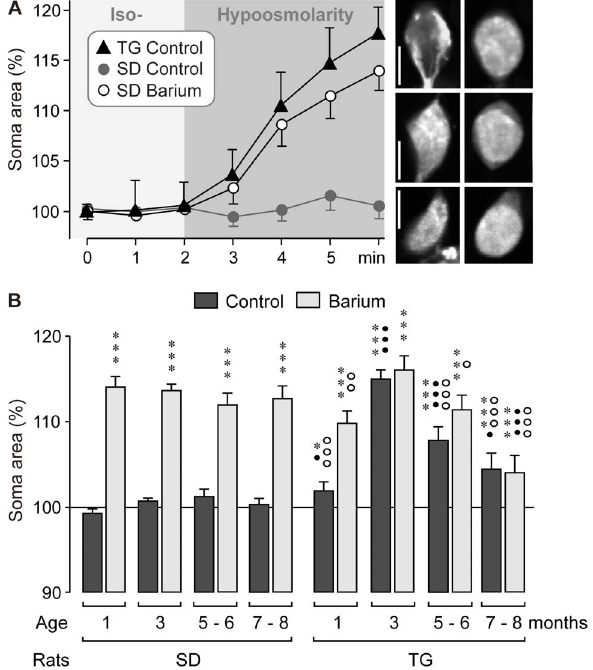
Figure 8. Age-dependent alterations in the osmotic swelling characteristics of Mu¨ller cell somata. Mu¨ller cell somata were recorded in retinal slices from control (SD) and transgenic (TG) rats. A. Time-dependent alterations in the mean cross-sectional area of cell somata (n=7–8 cells each) during the change from isoosmotic to hypoosmotic extracellular solution (60% osmolarity) in slices from 3- Figure 9. Involvement of oxidative-nitrosative stress and months animals. Cells in slices from SD animals were recorded in the inflammatory lipids in the induction of osmotic Mu¨ller cell absence (control) and presence of barium chloride (1 mM). The images swelling. Retinal slices from 3-months control (SD; A ) and transgenic display original records of Mu¨ller cell somata in slices from 3-months TG (TG) rats ( B ) were used. The cross-sectional area of Mu¨ller cell somata rats ( above and middle ) and a SD rat ( below ) obtained before ( above ) was measured after superfusion of the slices with hypoosmotic solution and during ( below ) superfusion with hypoosmotic solution in the for 4 min, and is expressed in percent of the soma size recorded before absence (TG rats) and presence of barium (SD rat). Bars, 5 m m. B. Mean hypoosmotic challenge (100%). A. The following agents induced cross-sectional area of Mu¨ller cell somata in dependence on the age of swelling of Mu¨ller cell somata in slices from control animals superfused the animals. The hypoosmotic solution was tested in the absence with hypoosmotic solution: barium chloride (1 mM), H 2 O 2 (100 m M), the (control) and presence of barium chloride (1 mM). The data were nitric oxide donor SNAP (5 m M), rotenone (100 nM), arachidonic acid measured after 4-min superfusion of retinal slices with hypoosmotic (AA; 10 m M), and prostaglandin E 2 (PGE 2 ; 30 nM). The reducing agent solution, and are expressed in percent of the soma size recorded before dithiothreitol (DTT; 3 mM), the nitric oxide synthase inhibitor L-NAME hypoosmotic challenge (100%). Each bar represents values obtained in (250 m M), and the peroxynitrite scavenger uric acid (1 mM) did not 14 to 80 cells from 2–10 animals. Significant swelling induction: N NNN induce swelling but prevented the swelling induced by barium. B. The * P , 0.05; *** P , 0.001. Significant difference between data from SD and hypoosmotic swelling of Mu¨ller cell somata in retinal slices from P , 0.05; P , 0.001. Significant difference vs . data of 3- TG rats: transgenic rats was abrogated in the presence of the following agents: months TG rats: # P , 0.05; ## P , 0.01; ### P , 0.001. the reducing agent dithiothreitol (DTT; 3 mM), the peroxynitrite scavenger uric acid (1 mM), the xanthine oxidase inhibitor allopurinol (100 m M), the NADPH oxidase inhibitor apocynin (100 m M), the inhibitor potassium conductance of mitochondria induces resistance to of the NADPH oxidase pathway and the uncoupling protein-2/ mitochondrial pathway, perindopril (4 m M), the inhibitors of the permeability transition [28]. We found that the opener of mitochondrial permeability transition cyclosporin A (CsA; 1 m M) and mitochondrial ATP-sensitive potassium (K ATP ) channels, pinacidil, minocycline (10 m M), respectively, the mitochondrial K ATP channel prevented the swelling of Mu¨ller cell somata in retinal slices from opener pinacidil (10 m M), the inhibitor of phospholipase A 2 4- 3-months transgenic animals (Fig. 9B). The assumption that a bromophenacyl bromide (Bromo; 300 m M), and the cyclooxygenase production of inflammatory lipid mediators is involved in swelling inhibitor indomethacin (Indo; 10 m M). The hypoosmotic swelling of Mu¨ller cell somata was decreased by the nitric oxide synthase inhibitor induction is supported by the facts that the inhibitor of L-NAME (250 m M). The selective cyclooxygenase-2 inhibitor celecoxib phospholipase A 2 activation, 4-bromophenacyl bromide, and the (1 m M) did not prevent hypoosmotic swelling of Mu¨ller cell somata. cyclooxygenase inhibitor indomethacin prevented the swelling of Each bar represents values obtained in 5 to 12 cells. Significant swelling NN NNN Mu¨ller cells from transgenic rats (Fig. 9B). On the other hand, the induction: ** P , 0.01; *** P , 0.001. Significant swelling-inhibitory effect: selective cyclooxygenase-2 inhibitor celecoxib did not prevent P , 0.01; P , 0.001. hypoosmotic swelling of Mu¨ller cell somata (Fig. 9B).